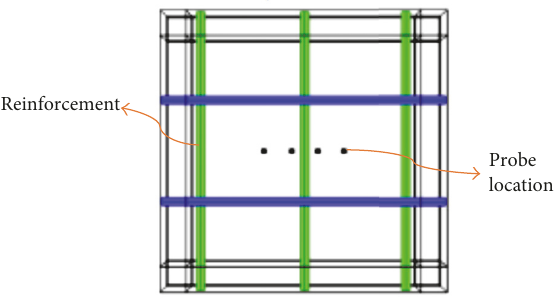
Figure 5: Probe configuration with respect to rebar mesh suggested to reduce electrical resistivity measurement error